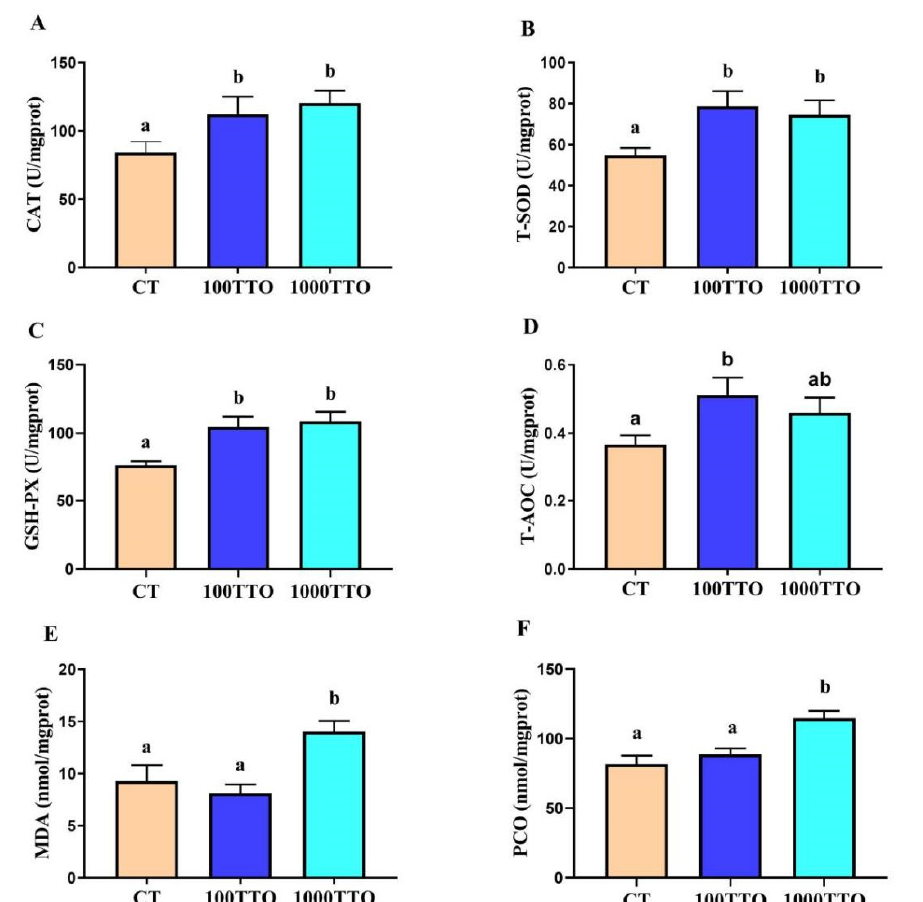
Figure 5. Effects of dietary TTO levels on the antioxidant level in the hepatopancreas of M. rosen ‐ bergii . ( A ) CAT activity; ( B ) T ‐ SOD activity; ( C ) GSH ‐ PX activity; ( D ) T ‐ AOC activity; ( E ) MDA con ‐ tent; ( F ) PCO content. The significant difference between the three TTO levels is characterized by different lowercase letters (a, b) ( p <